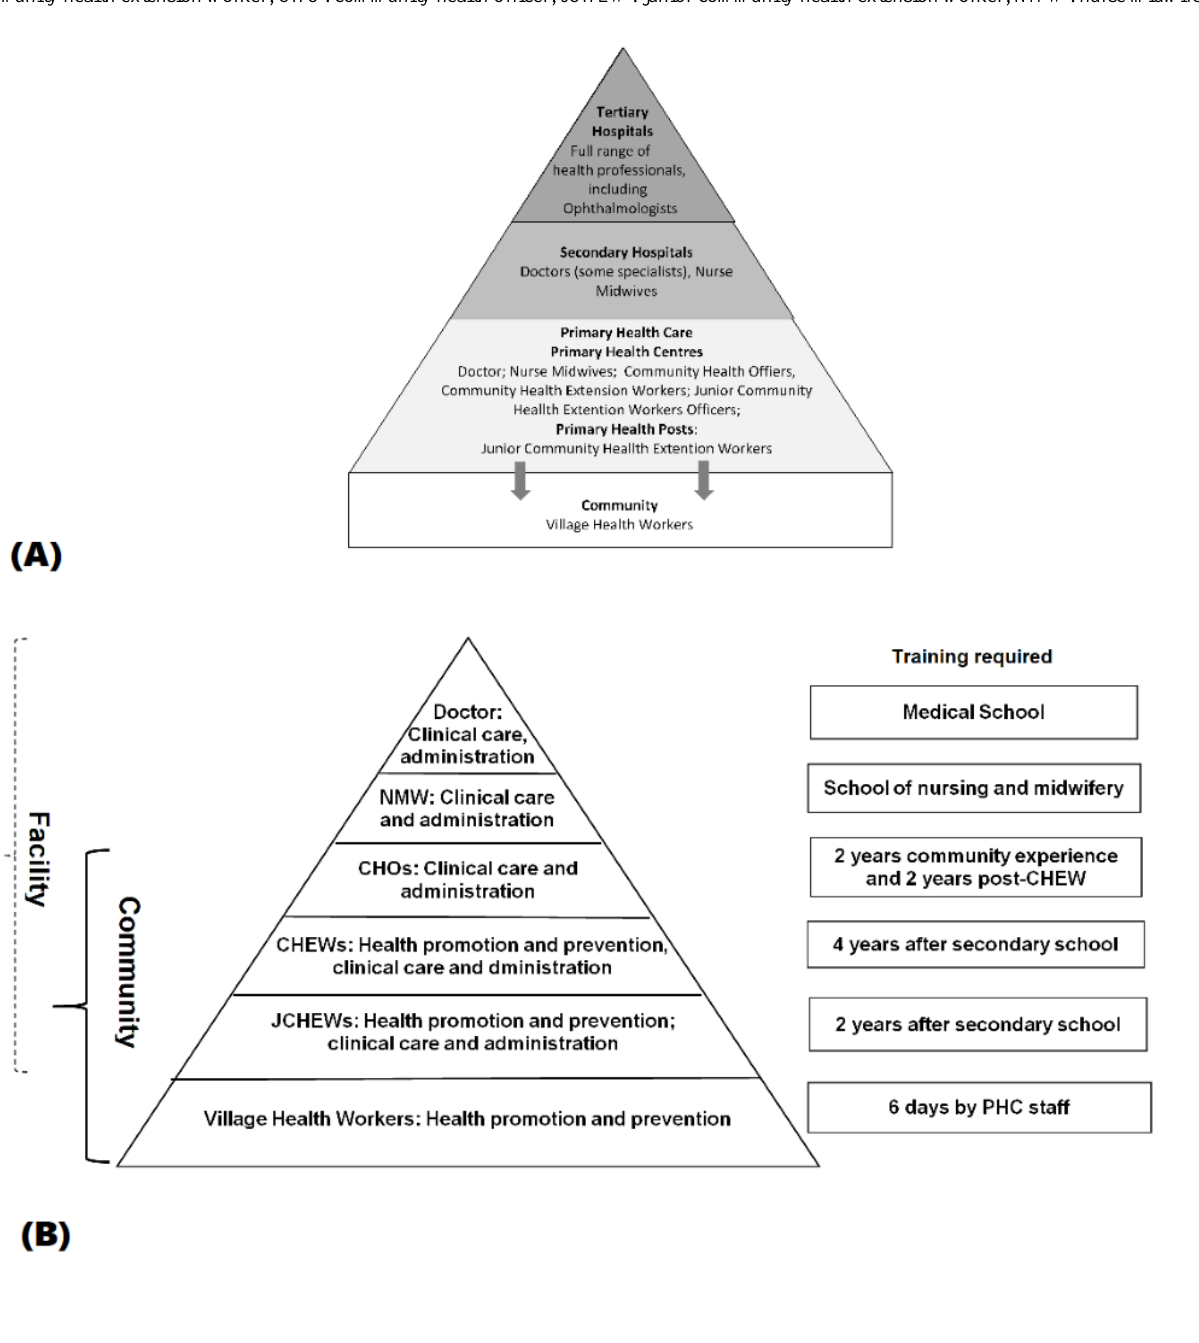
Figure 1. Human resources for health in Nigeria (A) across the tiers of the health system and (B) at primary health care (PHC) facilities.